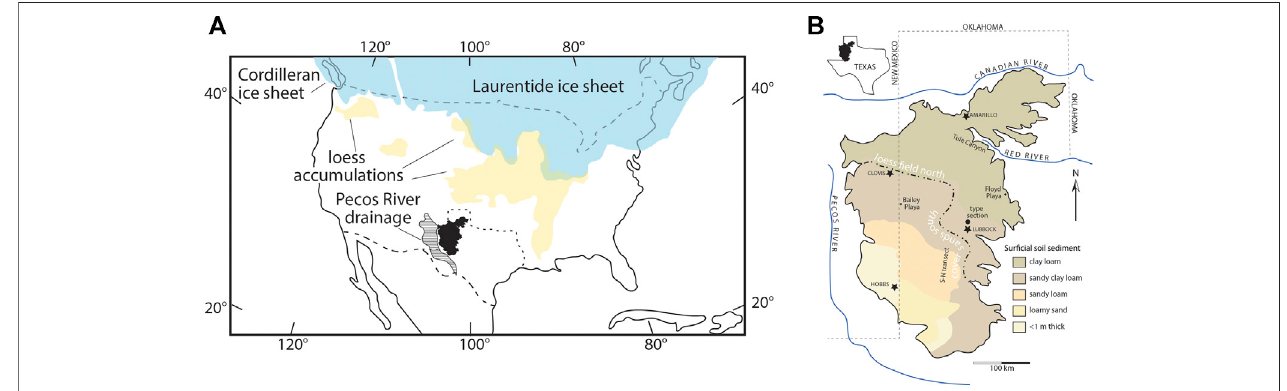
FIGURE 1 | ( A ) The North American continent during the Last Glacial Maximum (LGM), with emphasis placed on the location of major loess accumulations, the maximumextentofNorthernHemisphereicesheetsduringtheLGM,andthePecosRiverdrainagearea.Distributionofloessisadaptedfrom(Muhs,2018),andsources therein). Extent of ice sheets is adapted from (Dyke et al., 2002). ( B ) Geographic extent of the Southern High Plains showing areas discussed in the text. Dashed line in center of the Southern High Plains de fi nes the inferred boundary between loess and cover sands (after (Reeves and Mahaney, 1976)). Figure modi fi ed from (Stine et al.,